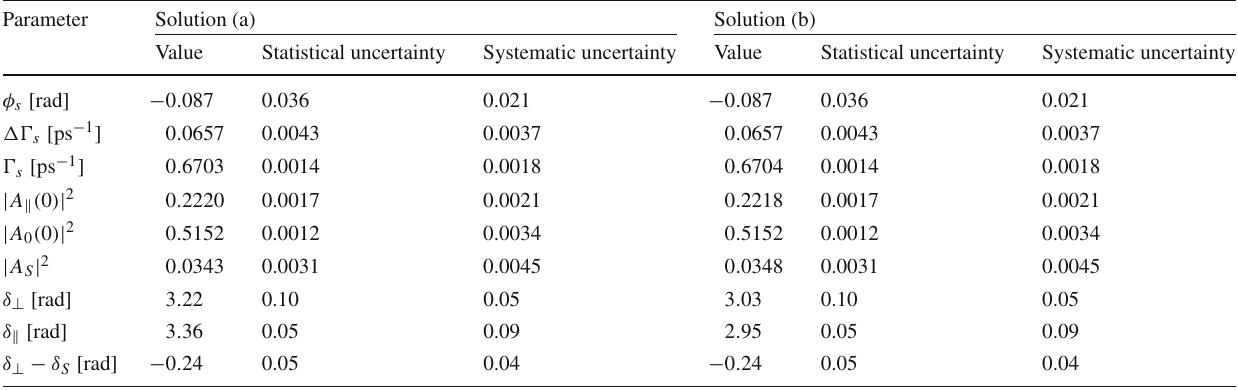
Table 9 Values of the physical parameters extracted in the combination of solution (a) and solution (b) of 13 TeV results with those obtained from 7 and 8 TeV data Parameter Solution (a) Solution (b) Value Statistical uncertainty Systematic uncertainty Value Statistical uncertainty Systematic